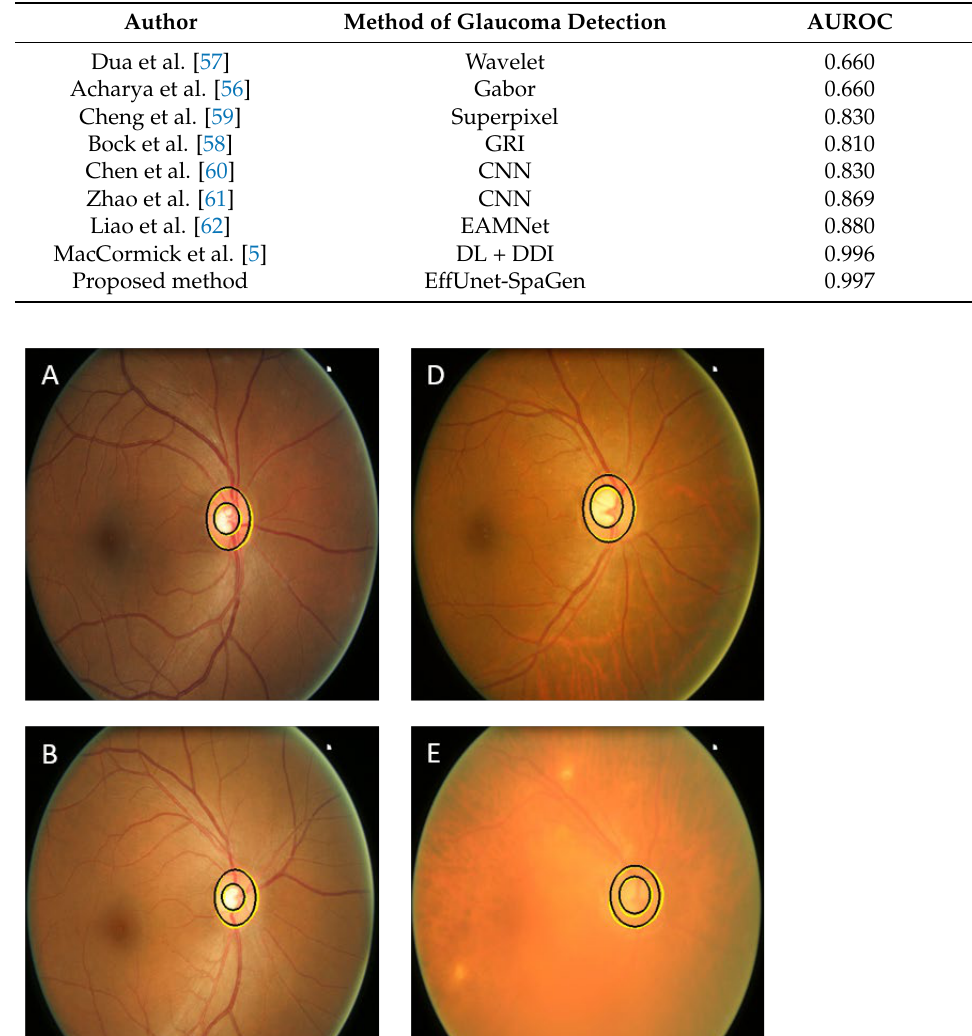
Table 6. Detection of glaucoma in ORIGA. The training set is ORIGA-A and the test set is ORIGA-B.